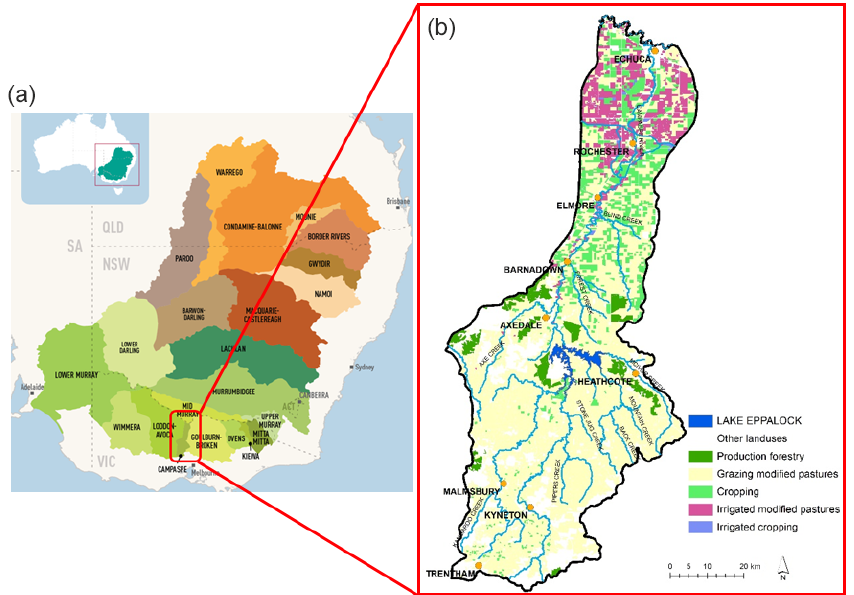
Figure 1. Panel (a) depicts the Campaspe catchment in the Murray-Darling Basin (adapted from MDBA, 2017) while (b) shows the Cam- paspe catchment proper with land use in the region.